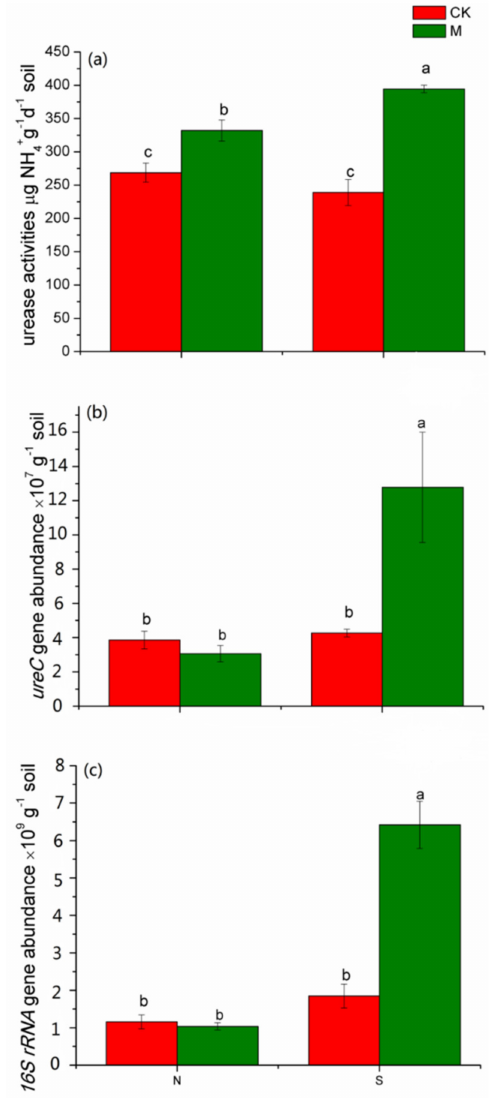
Figure 1. Urease activity ( a ), abundance of ureC ( b ) and 16S rRNA ( c ) genes. Error bars represent standard errors of three replicates. Bars with different letters (shown above each bar) were found to be significantly different ( p < 0.05) by Fisher’s LSD test ( p < 0.05). Abbreviations: N, north site; S, south site; CK, no fertilization; M, organic manure